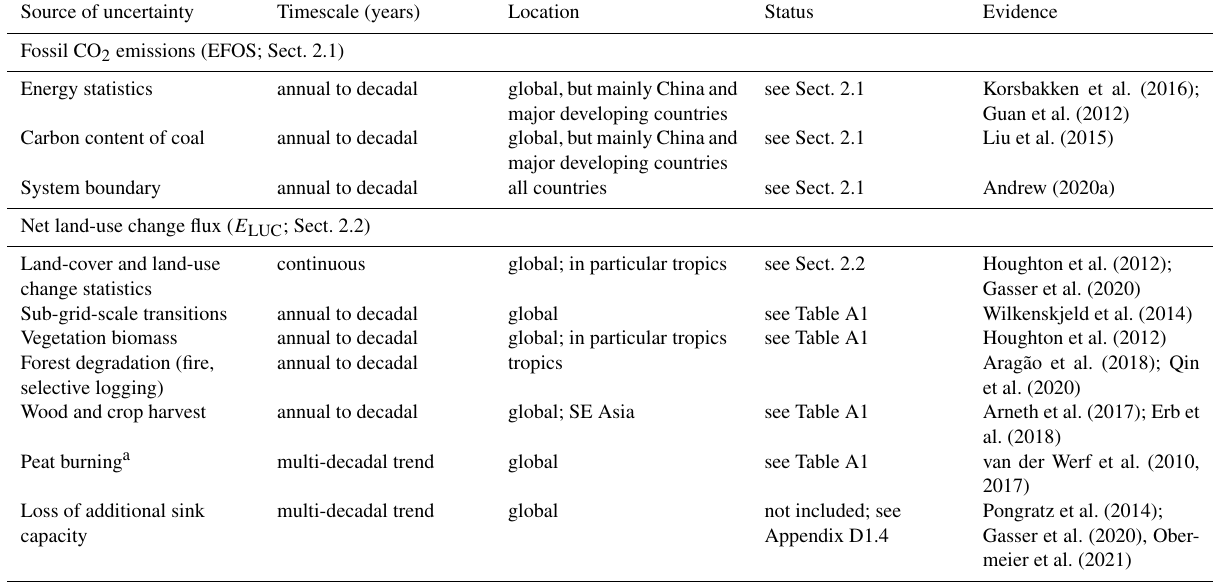
Table 9. Major known sources of uncertainties in each component of the Global Carbon Budget, defined as input data or processes that have a demonstrated effect of at least ± 0.3GtCyr − 1